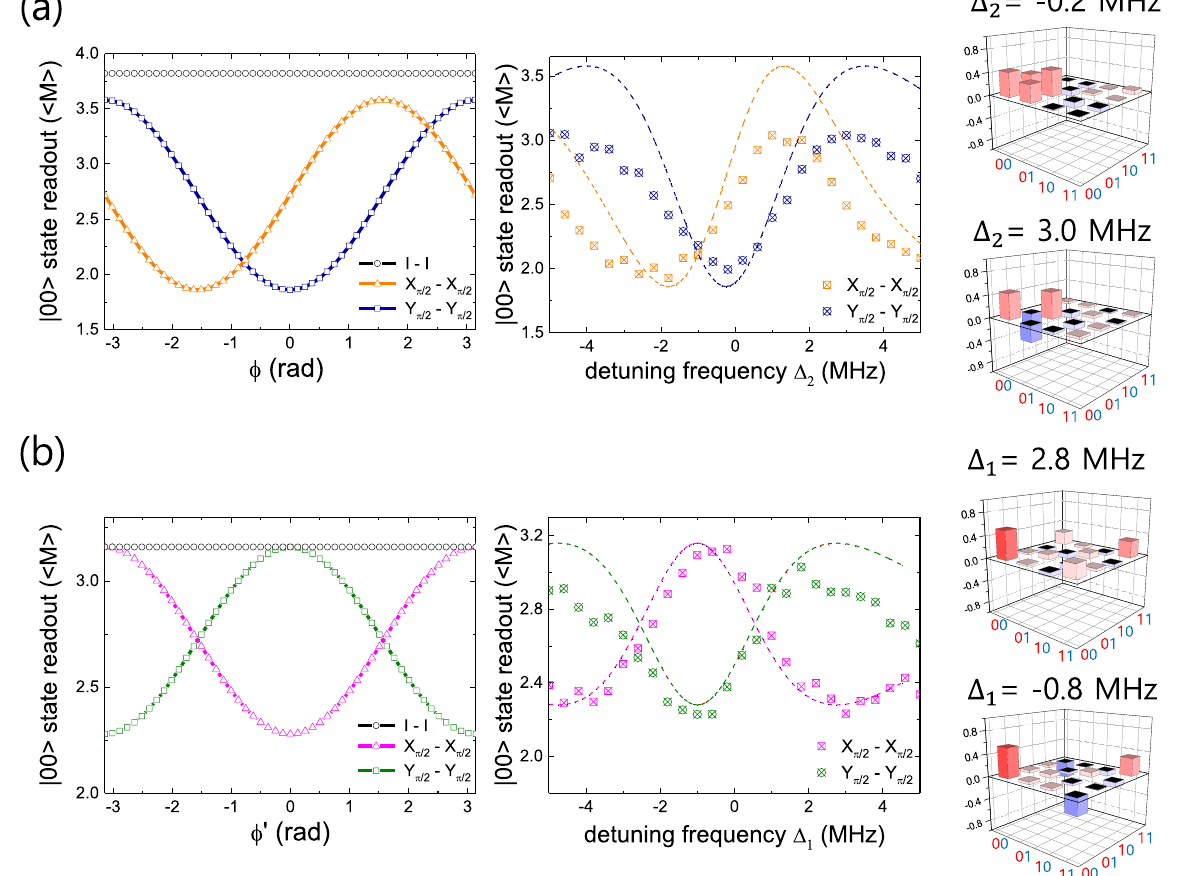
Figure 3. ( a ) Left: Theoretical estimation of applying protocols of three different pre-pulses, ⊗ I I (black open circle), ⊗ π π X X (orange open triangle) and ⊗ π π Y Y (navy open square) on the state | 〉 + | 〉 φ e ( 00 01 ) i 1 . /2 /2 /2 /2 2 Middle: Experimental result of applying protocols of pre-pulses ⊗ π π X X (orange cross square) and /2 /2 ⊗ π π Y Y /2 /2 (navy cross circle). Dotted lines are borrowed from the left. Right: The reconstructed density matrix by two-qubt QST. Δ 2 = − 0.2 MHz (top) and 3.0 MHz (bottom). (See the main text for the detailed explanation) ( b ) Left: Theoretical estimation of applying protocols of three different pre-pulses, ⊗ I I (black open circle), φ ′ e ( 00 11 ) i 1 ⊗ ⊗ . Middle: π π X X /2 /2 (pink open triangle) and π π Y Y /2 /2 (green open square) on the state | 〉 + | 〉 2 Experimental result of applying protocols of pre-pulses ⊗ π π X X (pink cross square) and ⊗ π π Y Y (green /2 /2 /2 /2 cross circle). Dotted lines are borrowed from the left. Right: The reconstructed density matrix by two-qubt QST. Δ = 2.8 MHz for the top and − 0.8 MHz for the bottom with Δ − 0.2 MHz as determined above. (See 1 2 is fixed at the main text for the